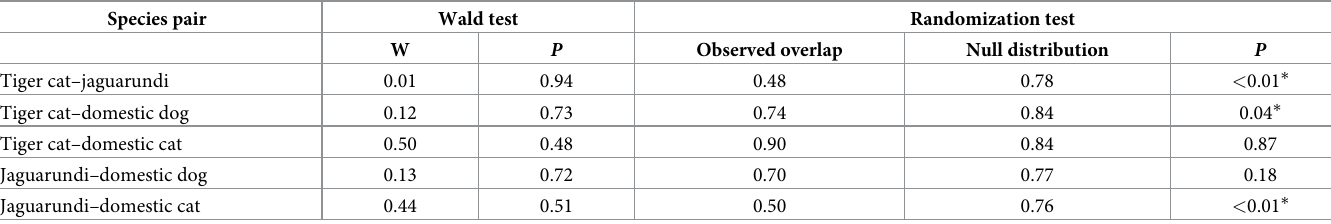
Table 3. Pairwise comparison of species’ diel activity levels and patterns at the Tamandua´ Ranch. Species